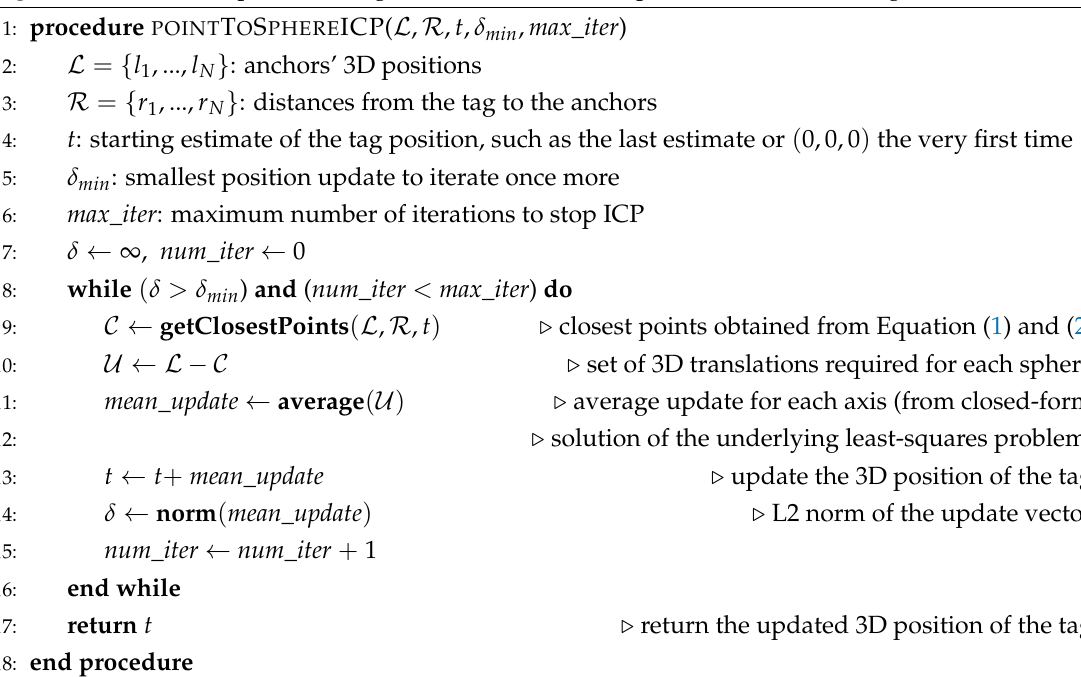
Algorithm 1 Point-to-sphere ICP algorithm to estimate the position of the UWB